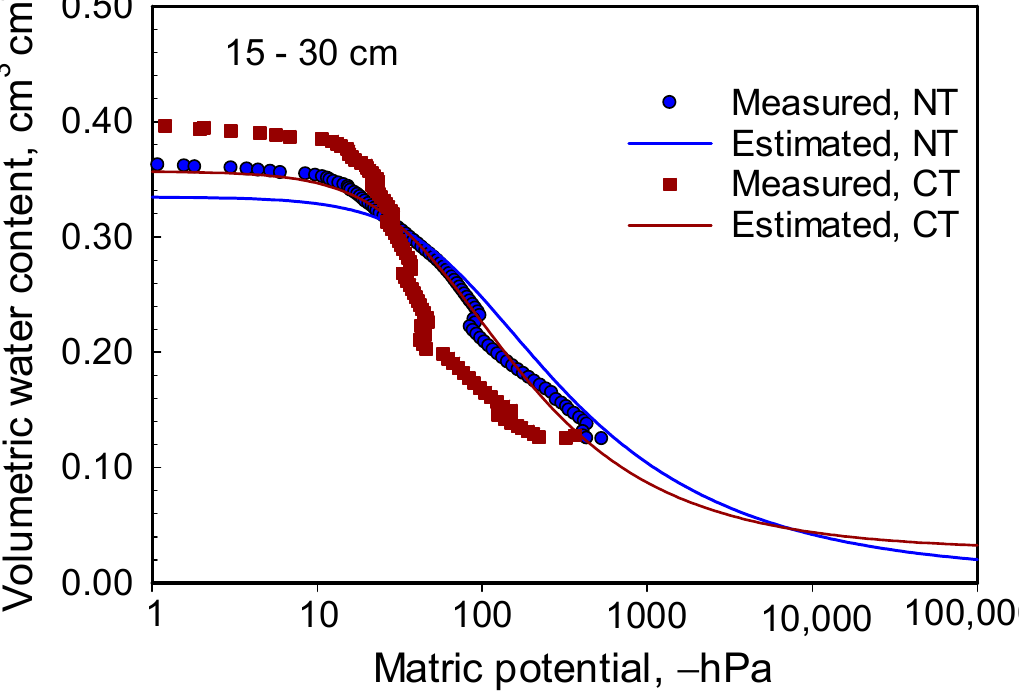
Figure 2. Soil–water retention curves for no-till (NT) and conventional tillage (CT) at a 15–30 cm soil depth.